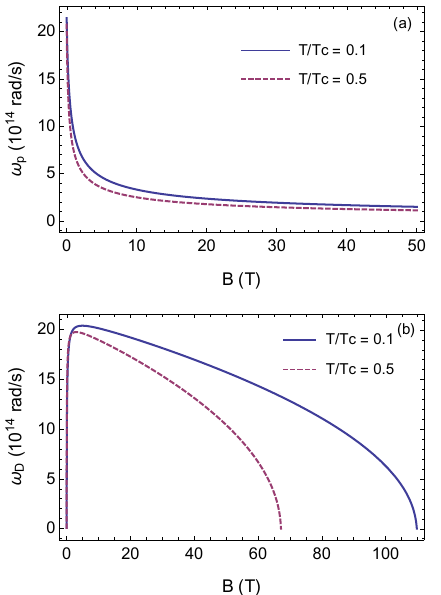
Figure 3. Dependence of frequencies ( a ) ω p (plasma model) and ( b ) ω field at t = 0.1 (solid line) and 0.5 (dashed